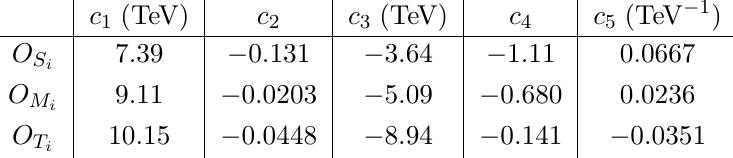
Table 4 . Results of c i in eq. (4.1) fitted with the training